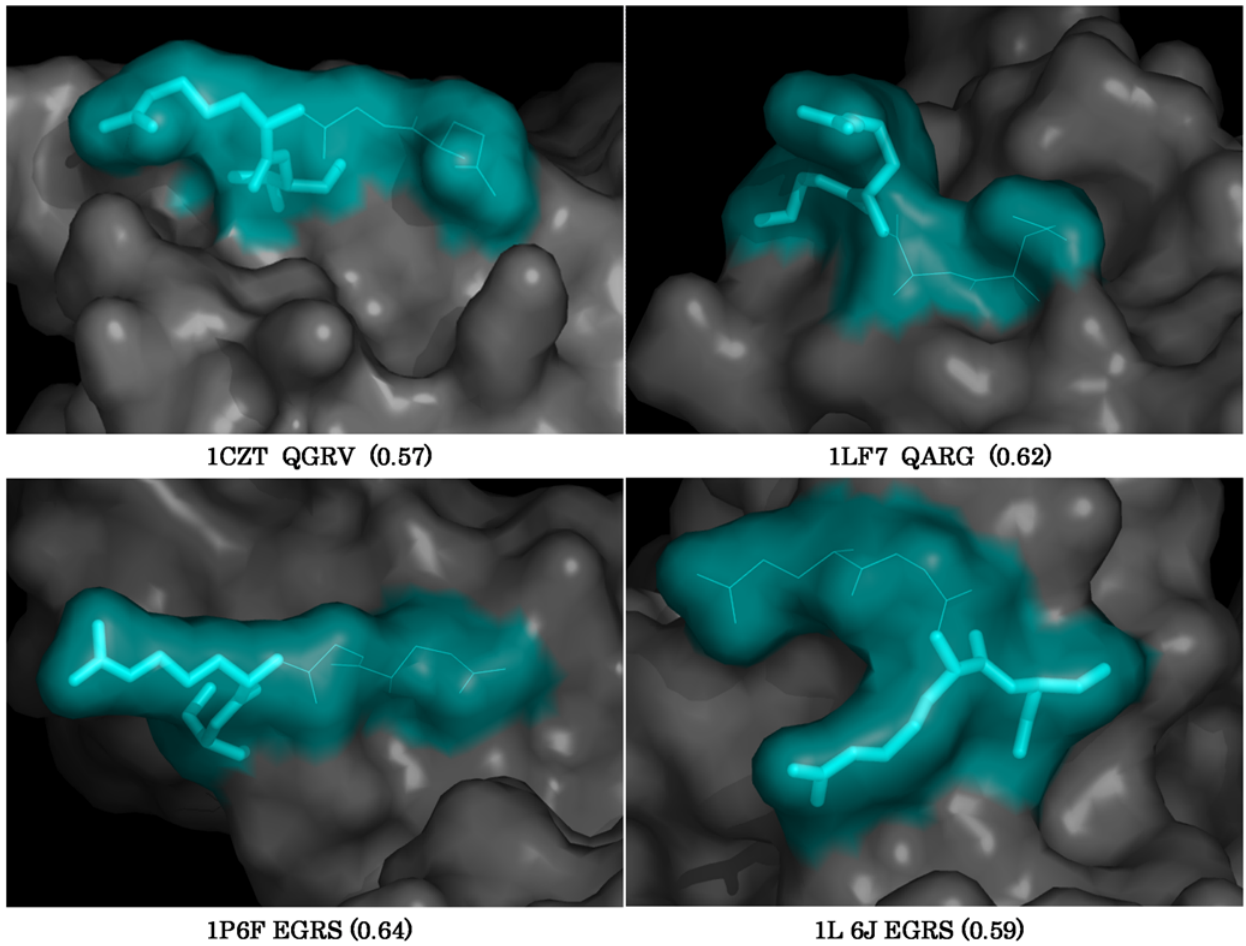
Figure 3. Three dimensional context of the cleavage sequences in putative substrates of matriptase. Structures of the putative substrates of matriptase with their tetrapeptide cleavage sequences are depicted in the format described in Figure 1.